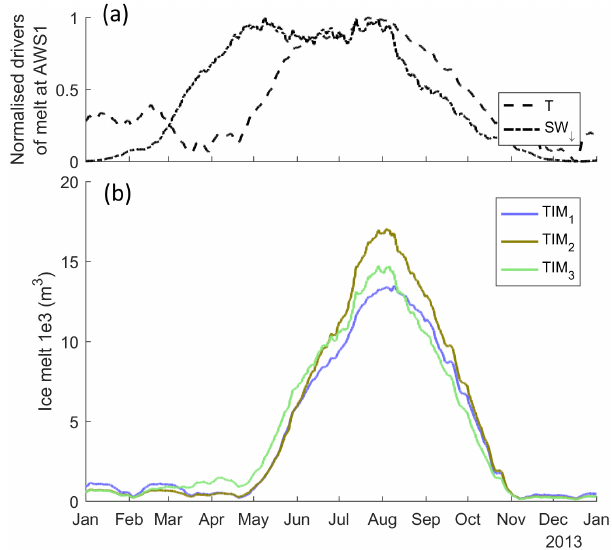
Figure 13. Mean simulated hourly ice melt (a) and river dis- charge (b) during May 2013 using the top 1% of models from the three melt model structures in combination with the ROR 1 run-off- routing model structure.